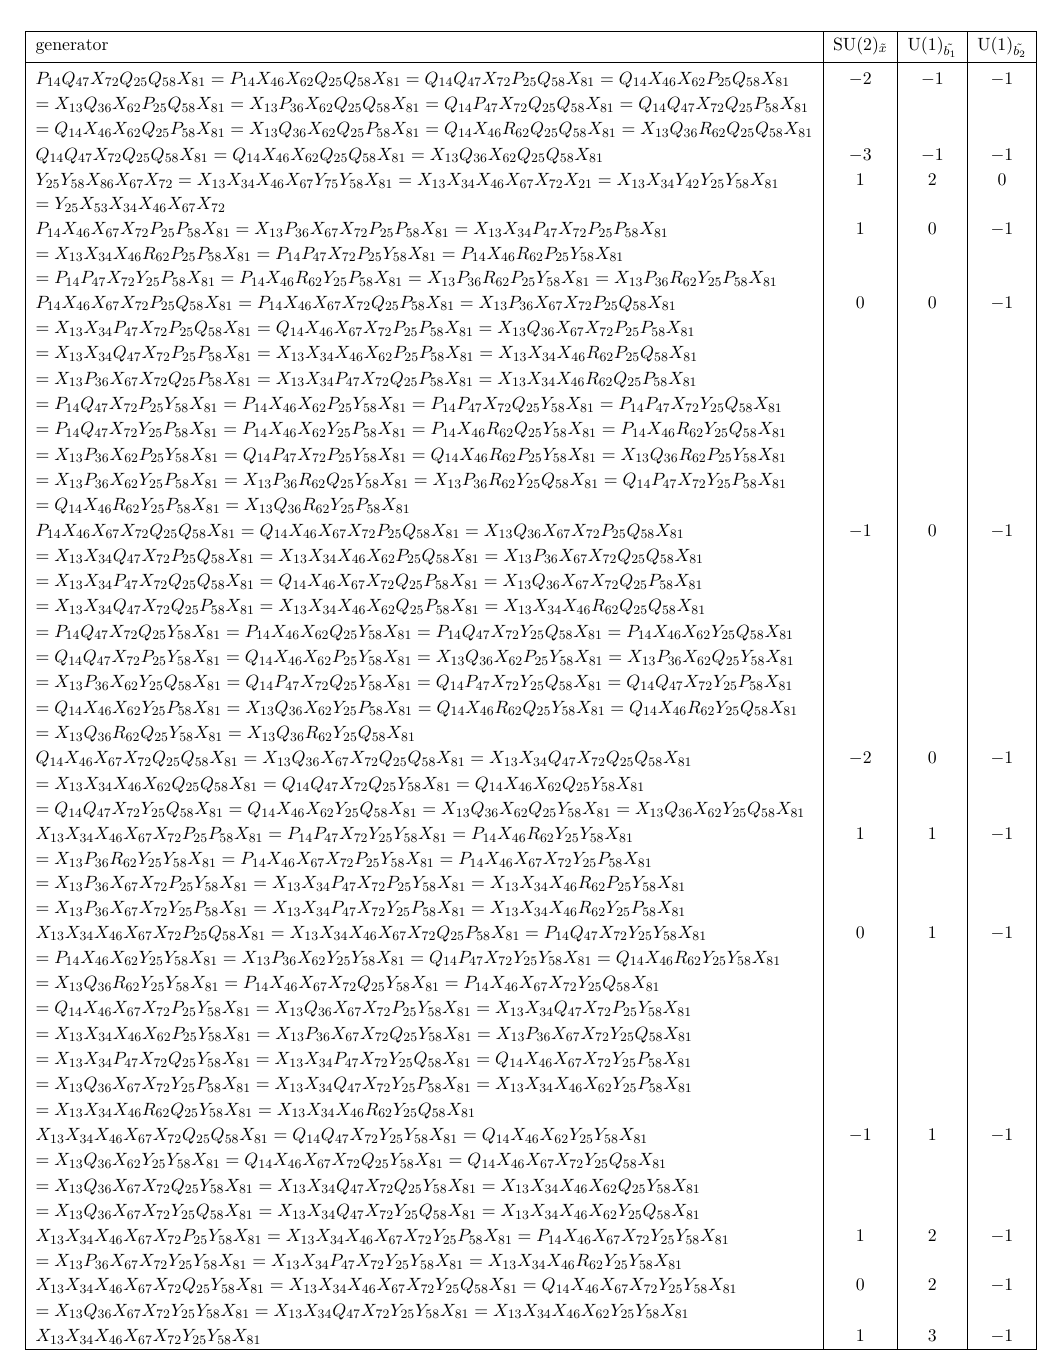
Table 34 . The generators in terms of bifundamental chiral fields for Model 8 (Part 2) .